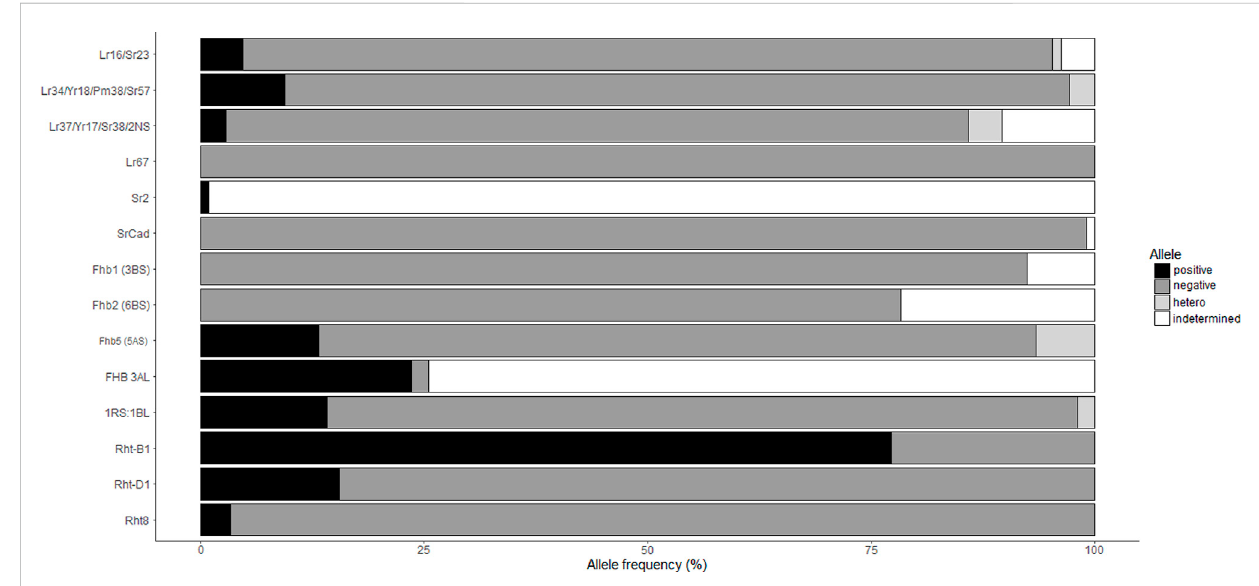
FIGURE 6 Alleles frequency in the Brazilian collection. The Brazilian cultivars (106, except Rht8 — 60 cultivars, Rht-B1 — 101 cultivars and Rht-D1 — 103 cultivars) were genotyped with molecular markers related with genes/loci of traits of interest. Each material was classi fi ed as positive (colored as black), negative (dark grey), heterozygous (light grey) or indetermined (null or questionable allele, white). Markers related with resistance genes, positive allele means presence of the resistant allele and negative represents the susceptible allele. For the 1RS:1BL , positive allele represents presence of the translocation. For all others, positive represents the mutant allele and negative is the